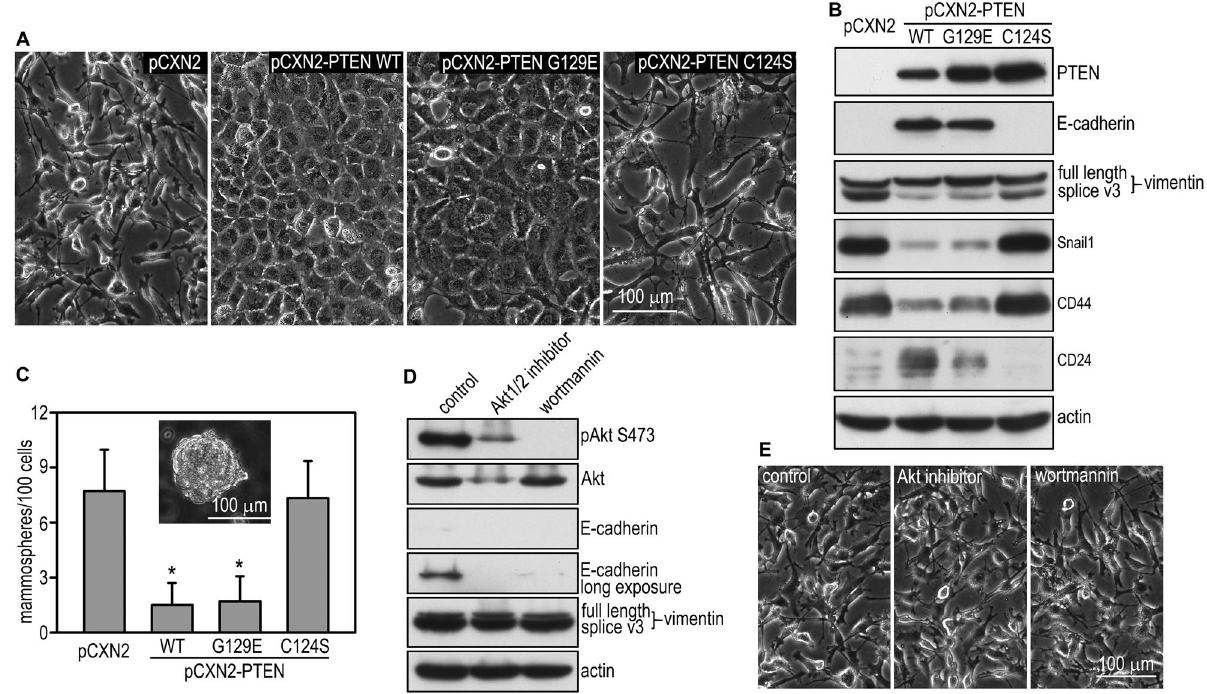
Figure 3. The protein phosphatase activity of PTEN confers an epithelial phenotype. ( A ) Live phase contrast micrographs show BT549 cells stably transfected with wild-type PTEN, PTEN G129E, C124S, or the vector alone. ( B ) Stably transfected BT549 cells were subjected to immunoblot analysis. Actin served as a loading control. Splice V3: splice variant 3. ( C ) BT549 cells were cultured in suspension for 7 days and mammosphere formation was counted. Transfection with wild-type PTEN and G129E but not C124S reduced mammosphere formation. N = 24, * P < 0.01. ( D ) BT549 cells treated with the PI3K inhibitor wortmannin (1 µM), the Akt 1/2 inhibitor (10 µM), or vehicle alone for 48 h were analyzed by immunoblotting for Akt phosphorylation as well as the mesenchymal and epithelial markers. Actin served as a loading control. ( E ) Live phase contrast micrographs show control and inhibitor-treated